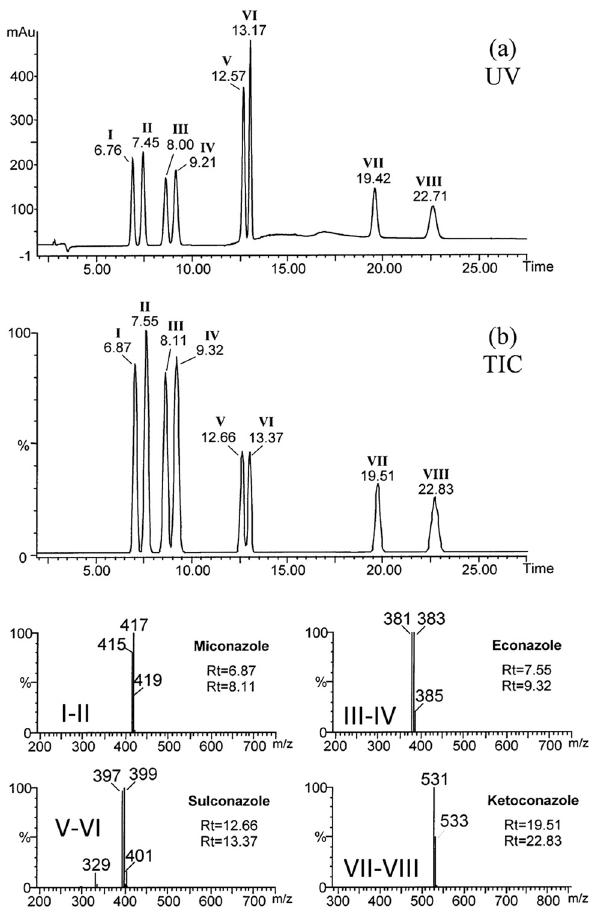
Figure 2: SFC chiral separation of four antimycotic drugs mixture by using LC - column packed with CSP - Amylose ( 3,5 - dimethylphenyl - carbamate )- based. ( a ) UV and ( b ) TIC chromatograms. ( I – VIII ) Mass spectra of target compounds. Adapted from ref. [ 74 ]